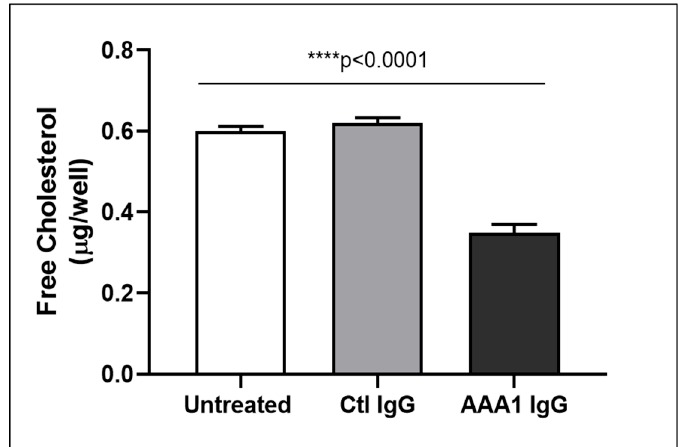
Figure 4. Free cholesterol in the cell supernatant. Free cholesterol content in J774 supernatant after exposure of cells to serum, anti-apoA-1 IgGs or control IgGs was expressed as μ g of free cholesterol per well. Data are expressed as the mean ± SD of the measurements done in triplicate and repeated three times ( n = 3). Statistical differences were determined by one-way analysis of variance (one-way ANOVA), with p ≤ 0.05 being considered significant.